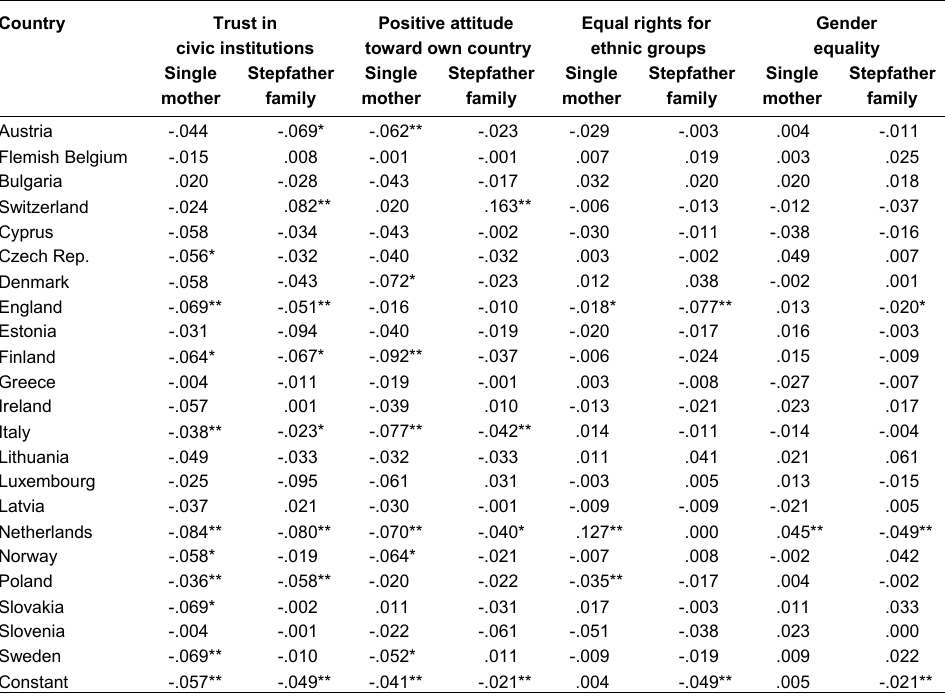
Table 2 : Societal attitudes of 13- and 14-year-old native students in single mother and stepfather families compared to two-parent families (reference group). OLS regression standardized